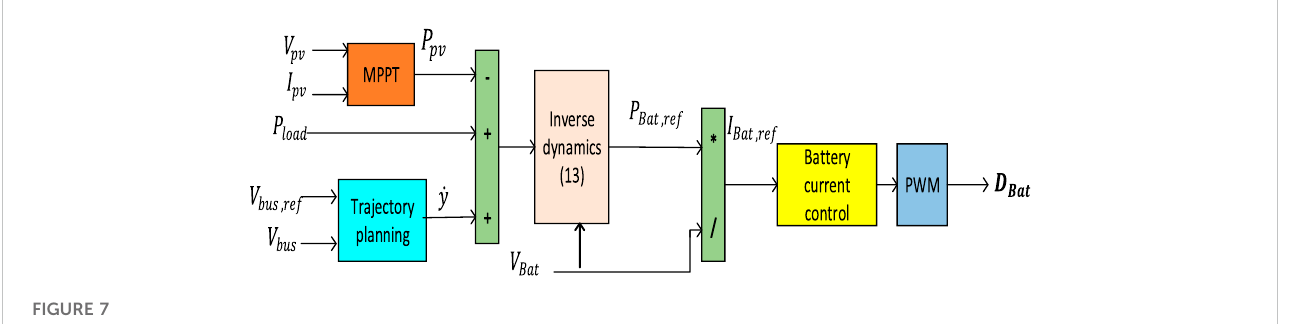
FIGURE 7 Proposed EMS of the hybrid PV-battery model.